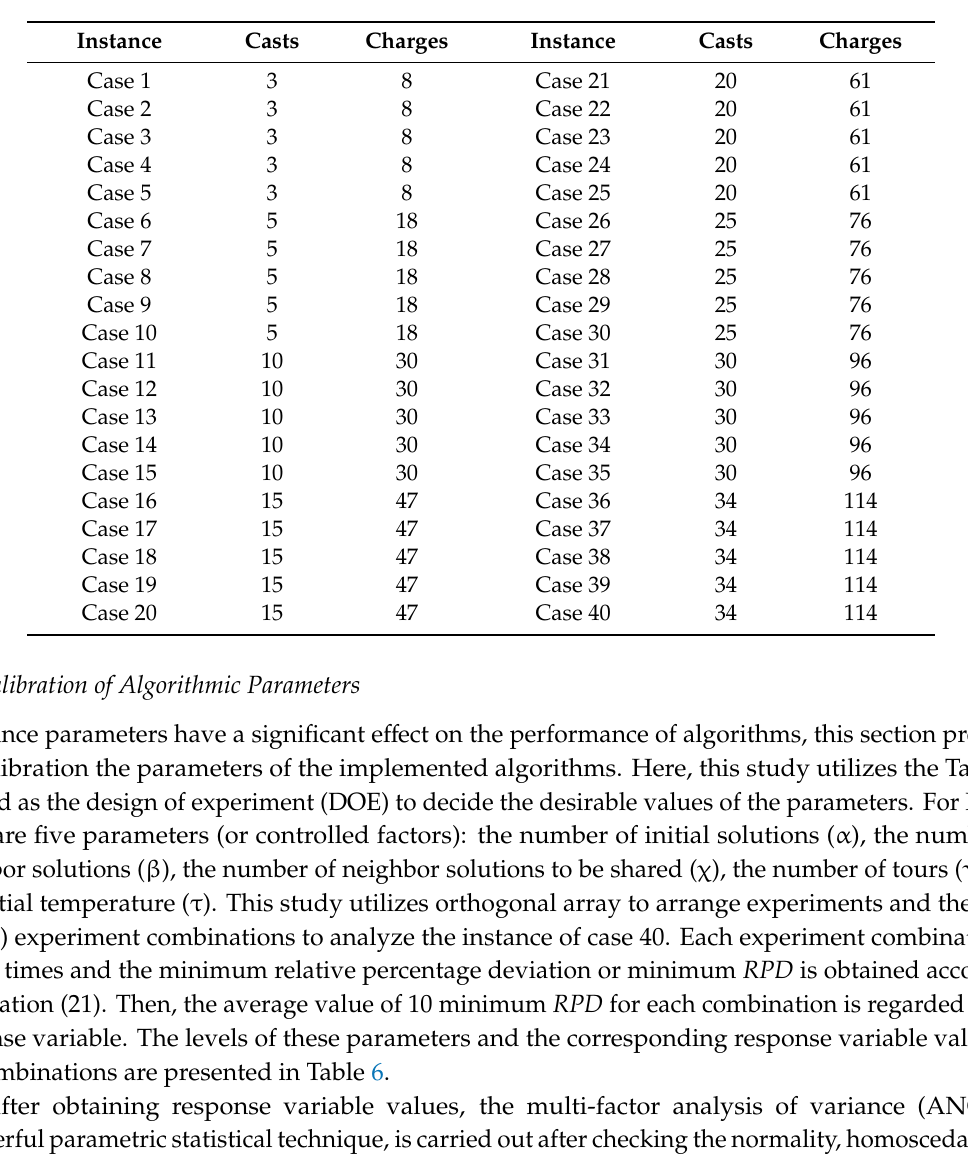
Table 5. The data for 40